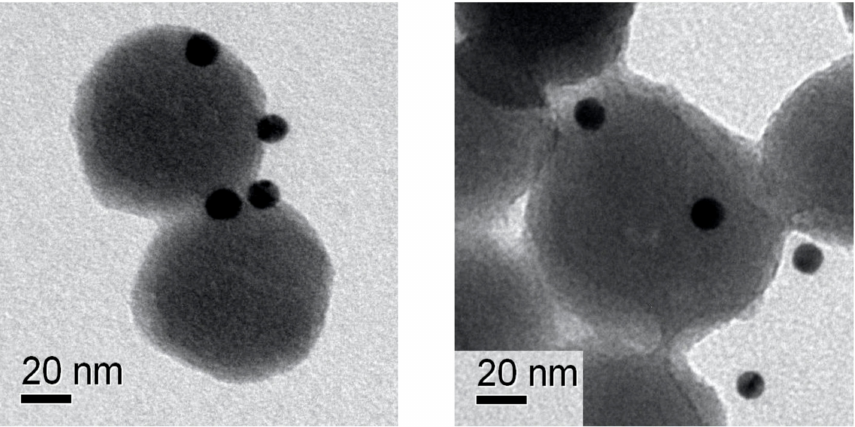
Figure 3. NPs immunolabeling. TEM images showing the epitope mapping of covalently bound CXCL5 on NPs surface by 10 nm immune-gold NPs (dark